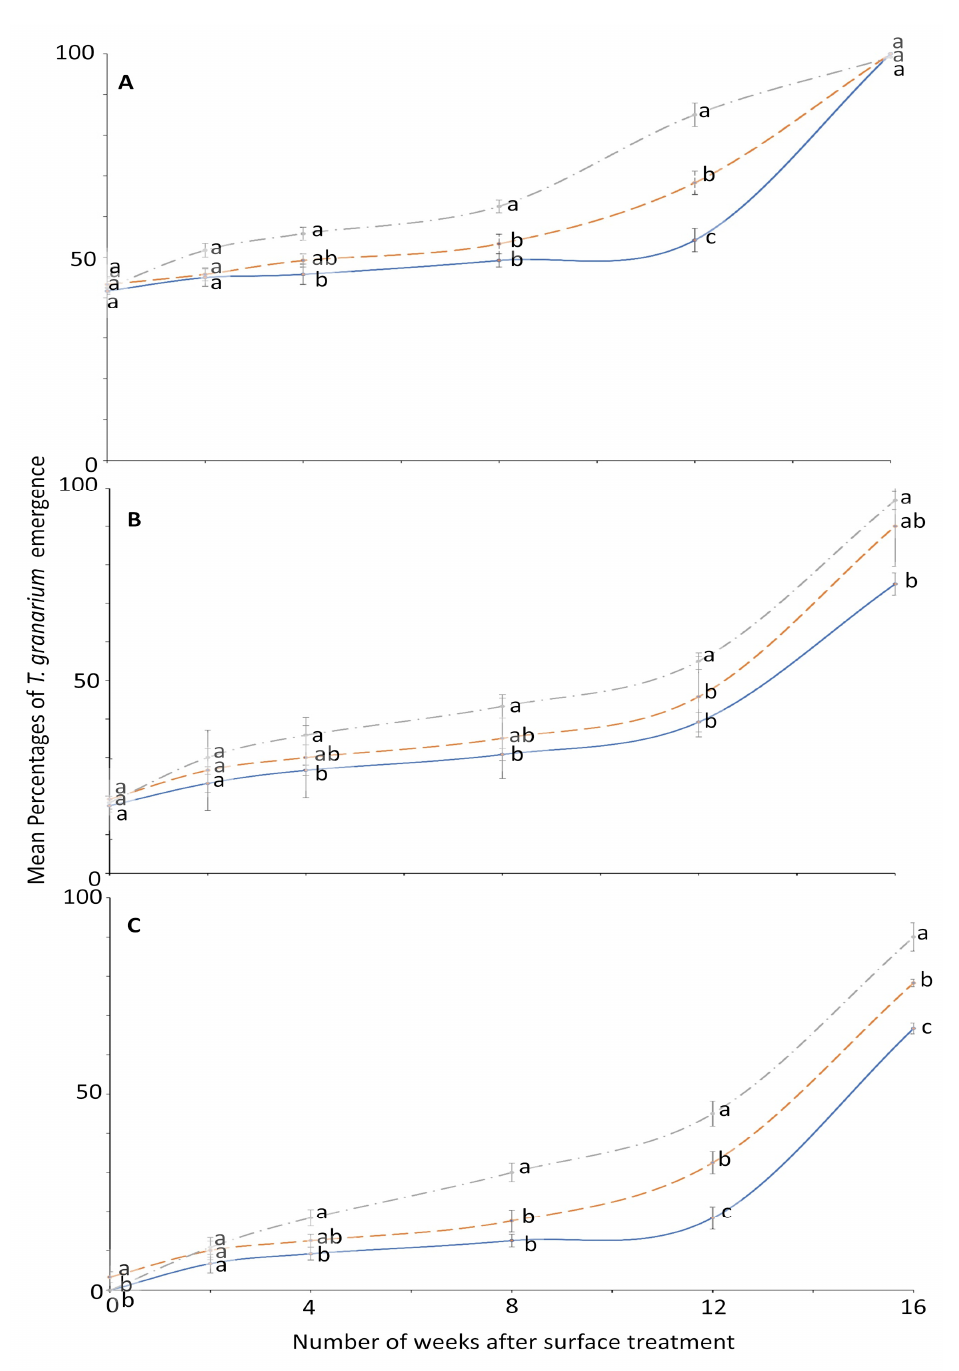
Figure 6. Mean percentages of adults emerging from last-instar T. granarium after exposure to novaluron applied 0–16 weeks previously to different surfaces: concrete (dashed line); metal, (solid line); or wood (dashed-dotted line) at concentrations of ( A ) 1-, ( B ) 2-, or ( C ) 4-ppm. In comparisons of mean emergence percentages from surfaces on a given week after application at a specified concentration, designated a–d above, percentages with the same letter are not significantly different.